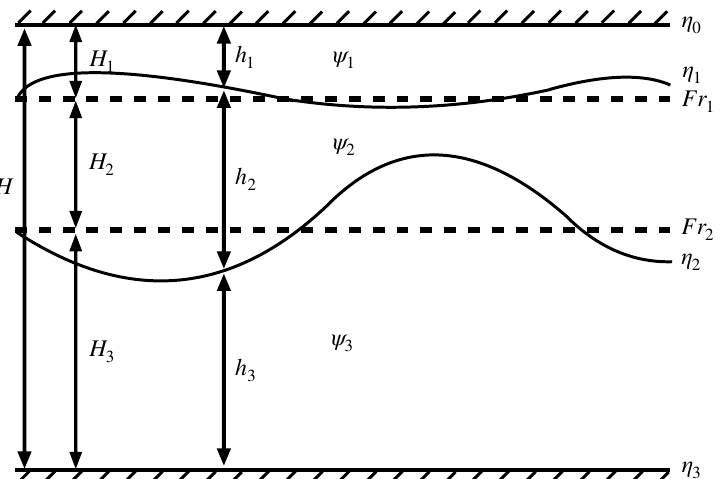
Figure 1. Vertical structure of the three-layer QG model with a rigid lid and flat bottom. The layer in- terface displacement ( η i ) is shown in the thin curvy lines and net layer thickness is h i = H i + η i − 1 − η i . The stream functions ( ψ i ) are defined within each